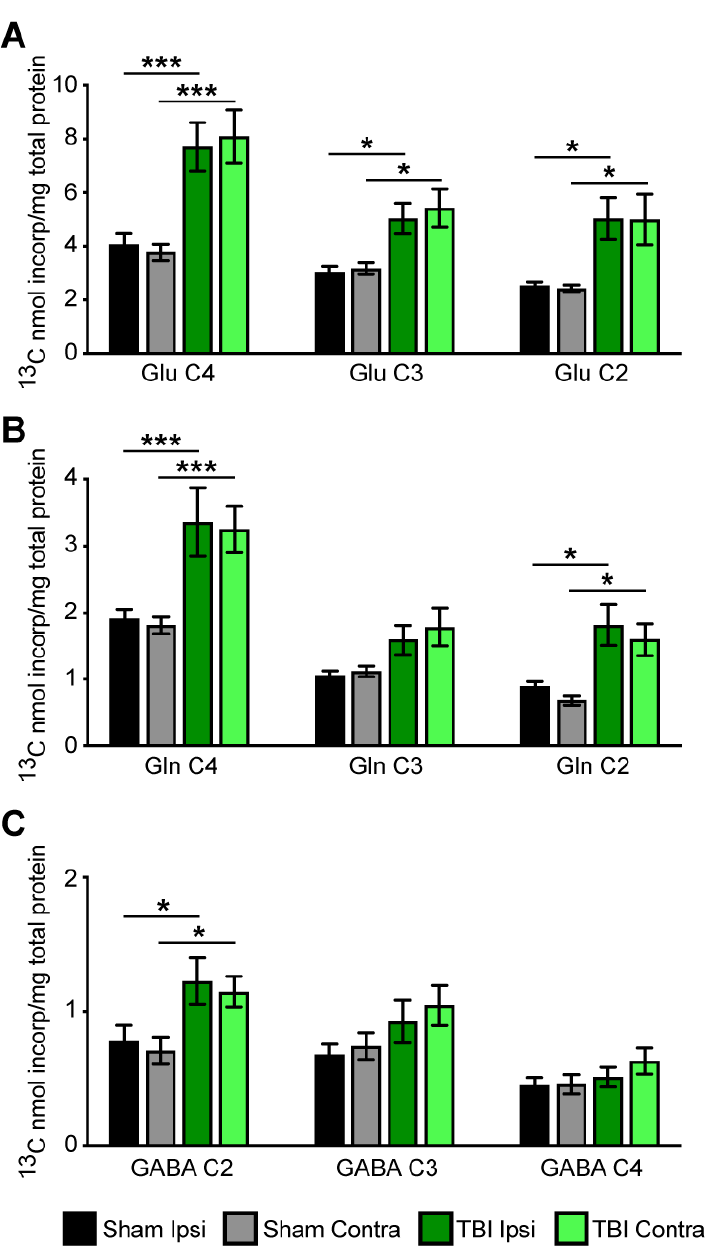
Figure 4. Incorporation of label from the metabolism of [2,4- 13 C] β -hydroxybutyrate into specific carbons (isotopomers) of ( A ) glutamate (Glu), ( B ) glutamine (Gln), and ( C ) GABA in ipsilateral and contralateral cortico-hippocampal formations in sham (grey bars) and TBI-operated (green bars) animals. Values are mean ± SEM nmol 13 C incorporated/total mg of protein; n = 8 sham and n = 8 TBI. Data were analyzed by 2-way ANOVA with Bonferroni post-hoc analysis. *** p < 0.001; * p < 0.05.